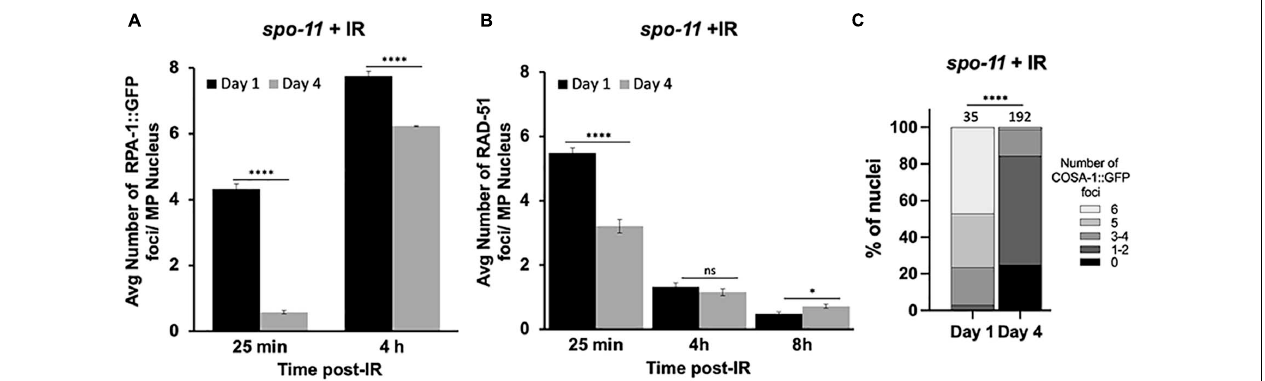
FIGURE 3 | Dynamics of RPA-1 and RAD-51 are altered in aging, meiotic germ cells. spo- 11 mutant worms at day 1 and day 4 of adulthood were exposed to 10Gy of γ -irradiation. (A) Average number of GFP::RPA-1 or B ) or RAD-51 in mid-pachytene nuclei at indicated timepoints post-exposure. A total of 10 worms per age/timepoint were analyzed in gfp::rpa-1; spo-11 (A) or spo-11 (B) worms. (C) Percent of late pachytene nuclei containing the indicated number of COSA-1 foci in gfp::cosa-1, spo-11 worms at 8 h post-exposure. Statistical significance was determined using Chi-square test. ns p > 0.1, ∗ p < 0.05, ∗∗∗∗ p <